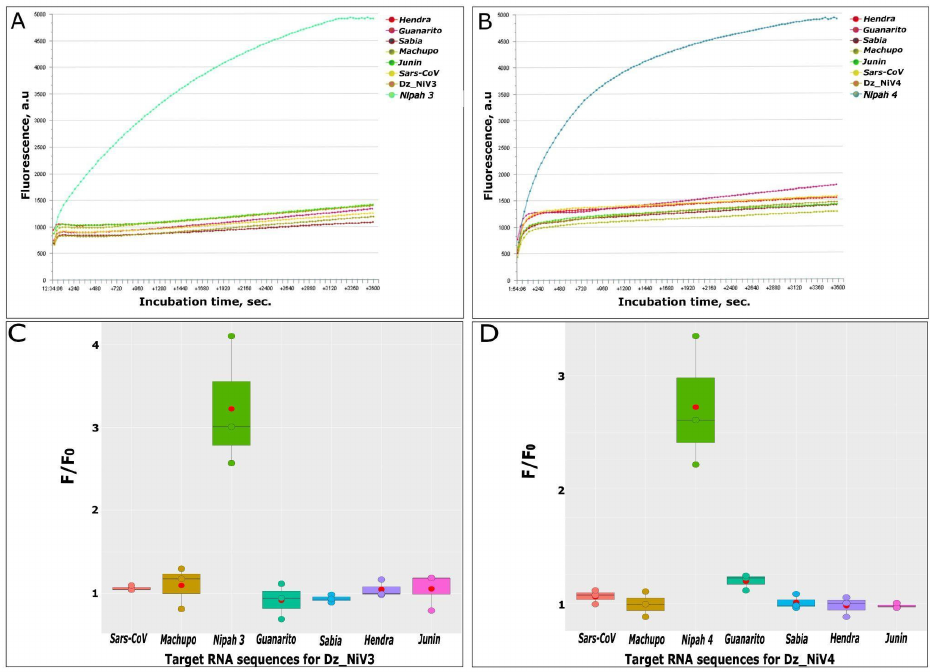
Figure 3. Selectivity of Dz_NiV3 ( A , C ) and Dz_NiV4 ( B , D ). Curves in the ( A , B ) images were directly obtained with the AxxinT16-ISO Isothermal Fluorescence Reader. Images ( C , D ) demonstrate fluorescence response from samples containing the different synthetic RNAs. Red dots on the graphs indicate the mean F1/F0 ratios.